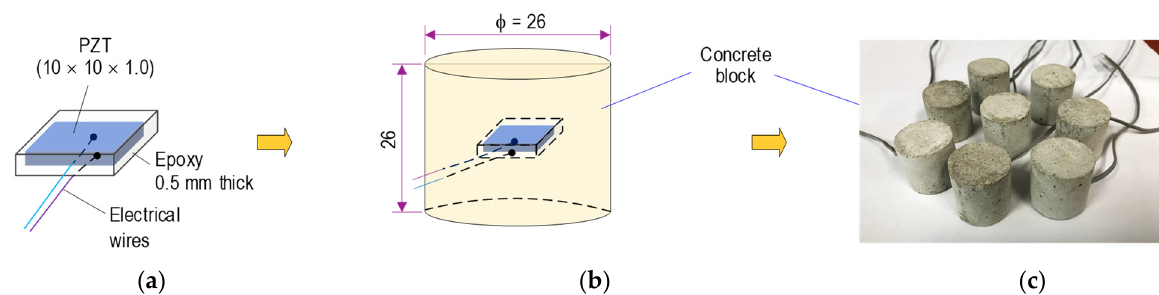
Figure 7. Prototype of PZT-embedded aggregate for impedance monitoring (unit in mm): ( a ) Covered PZT patch; ( b ) PZT embedded in concrete block, ( c ) Smart aggregate.